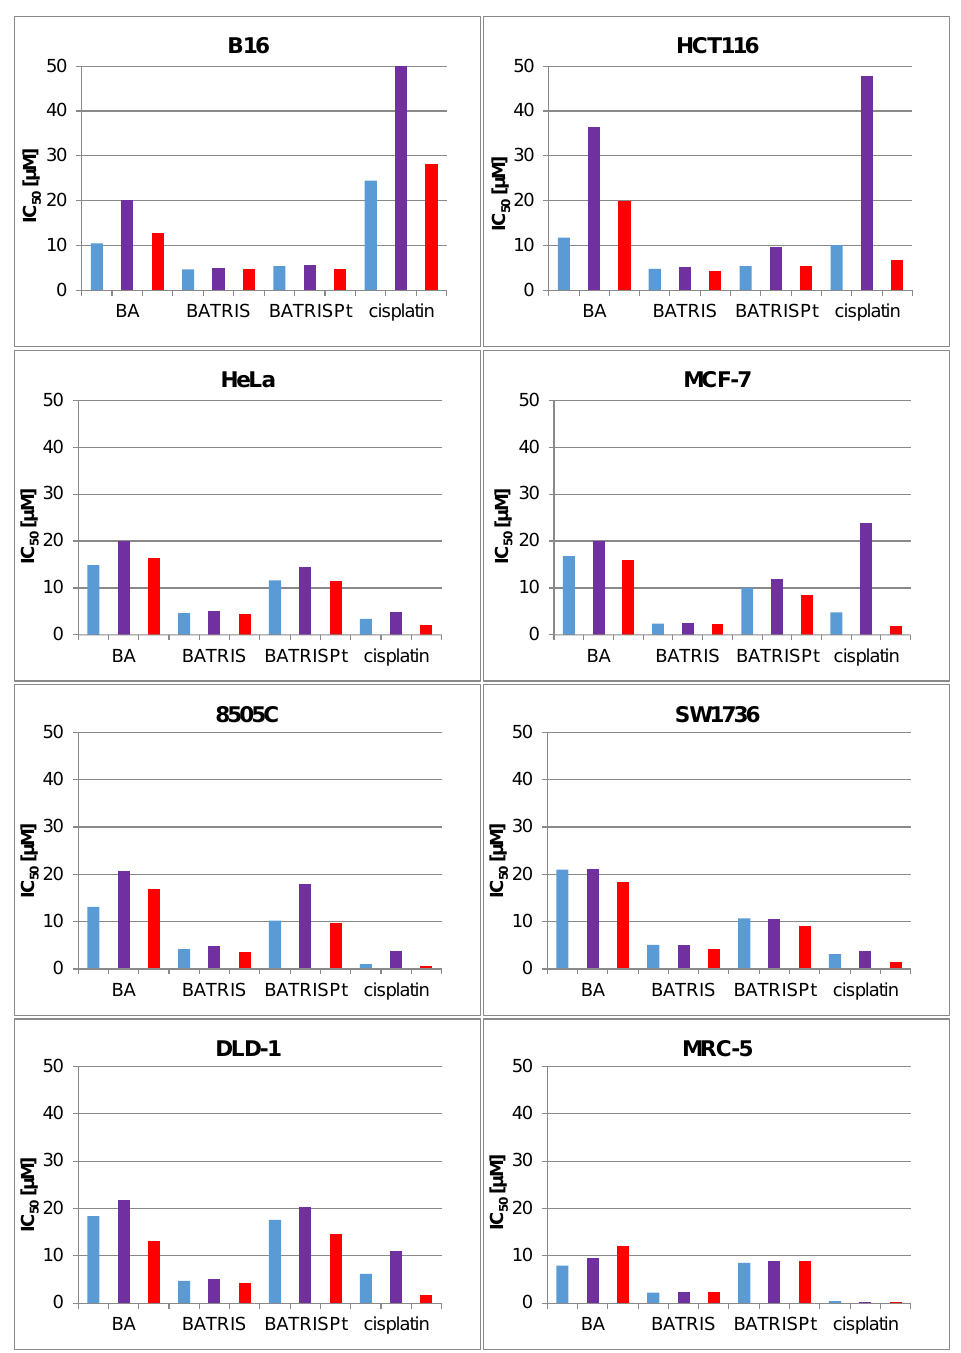
Figure 1. IC 50 values (µM) (SD < 10%) of the various tumor cells and normal fibroblasts MRC-5 treated with investigated compounds determined with MTT ( ■ ), CV ( ■ ) and SRB ( ■ ) assays (96 h). * IC 50 > 50 µM. BA: betulinic acid; BATRIS: acetylated betulinic acid tris(hydroxymethyl)aminomethane ester; BATRISPt: platinum(II) conjugate with BATRIS; CV: crystal violet; MTT: 3-(4,5-dimethythiazol- 2-yl)-2,5-diphenyltetrazolium